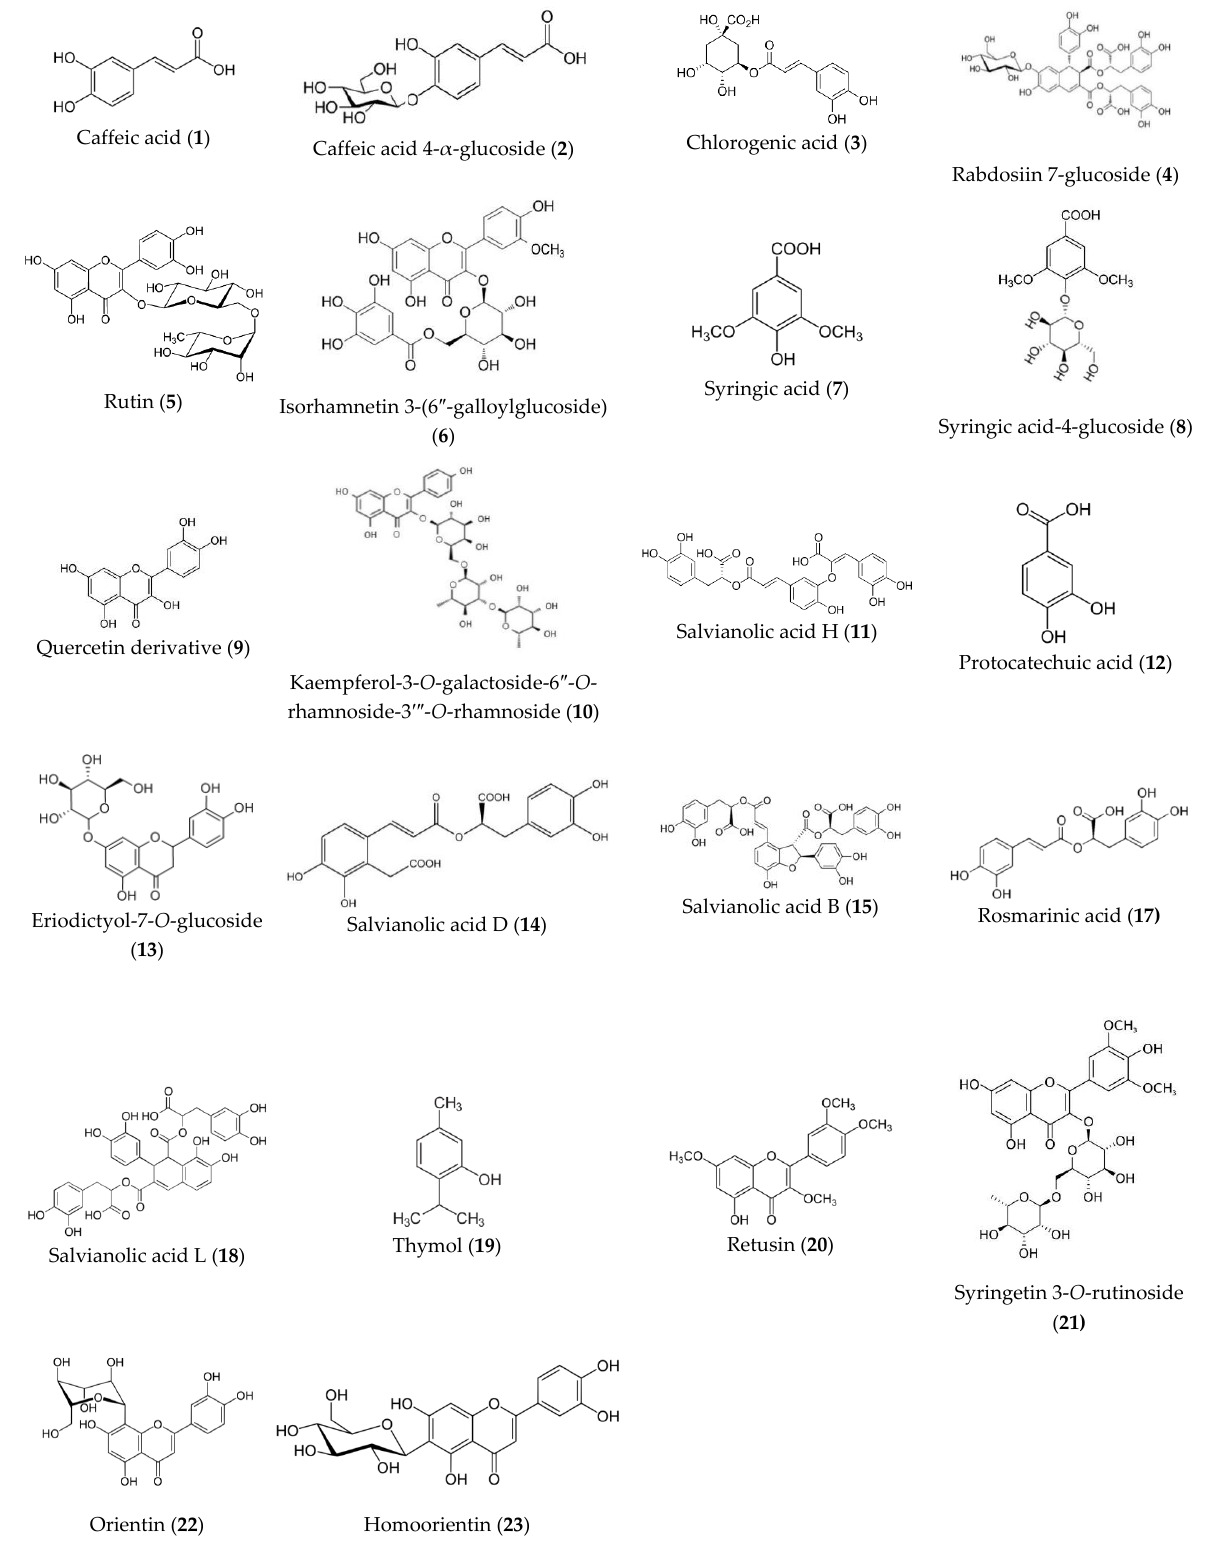
Figure 3. Main compounds of ethanolic extract from Origanum vulgare ssp . vulgare. Dihy- droxycinnamic acids ( 1 – 4 , 17 ); dihydroxybenzoic acids ( 12 ); syringic acids ( 7 , 8 ); essential oil ( 19 ); salvianolic acids ( 11 , 14 , 15 , 18 ); flavonoids ( 5 , 6 , 9 , 10 , 13 , 21 – 23 ). Dihydroxycinnamic acids (λ max 316 – 331 nm) were detected first in LC-MS analysis. They were also previously described in Lamiaceae species [53,58,68]. These compounds could be related to the blue spots on TLC (mobile phase: ethyl acetate:glacial acetic acid:formic acid:water (100:11:11:26, v/v/v/v )). One monomer, caffeic acid (compound 1 ), was identified at 0.9 min ( m/z 179.05, λ max 296sh, 324 nm). This compound yielded an ion at m/z 179.05 [M-H] − and a prominent frag- ment at m/z 135.04 [M-H-44] − through the loss of a CO 2 group. The extract also showed four more complex forms of caffeic acid (compounds 2 , 3 , 4 and 17 ). Fragment m/z 179.05 of caffeic acid appears in the mass spectra of all of them. Compound 2 at 1.1 min showing [M-H] − at m/z 341.07 and [M-H-162 (glucose residue)] − at m/z 179.03 was tentatively char- acterized as caffeic acid 4- α -D-glucoside. The loss of 162 amu is likely due to the cleavage of a glucose moiety. Chlorogenic acid (compound 3 ), a combination of caffeic acid and quinic acid ( m/z 354.31), was also detected at 1.3 min. The highly intense characteristic ion at m/z 191.01 [M-H-162 (caffeoyl residue)] − corresponding to quinic acid confirmed the structure. Compound 17 was assigned to rosmarinic acid, an ester of caffeic acid and 3,4- dihydroxyphenyl lactic acid and it is widely described in Lamiaceae and Boraginaceae fam- ilies. The MS fragmentation of rosmarinic acid pseudomolecular ion ( m/z 358.97) lead to three peaks at m/z 197.01 [M-H-162 (caffeoyl)] − , 179.05 [M-H-180] and 161.02 [M-H-198] − ,